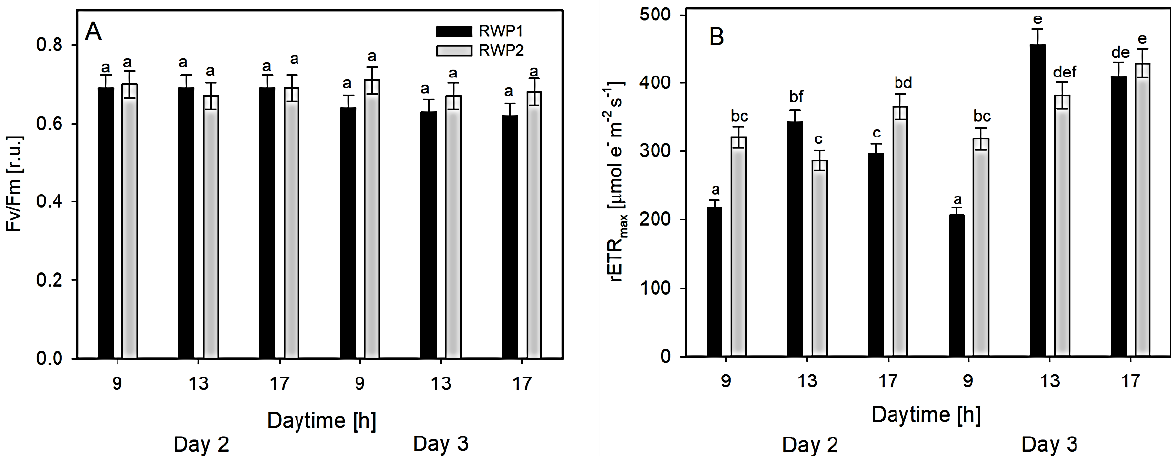
Figure 5. Variables Fv/Fm ( A ) and rETRmax ( B ) were estimated ex-situ using rapid light-response curves of Chl fluorescence. The column designation is identical in both panels. The data were measured in the culture samples taken at 09:00, 13:00, and 17:00 h from the bioreactors RWP1 and RWP2 on days 2 and 3. The mean values designated by the same letter did not differ significantly from each other.